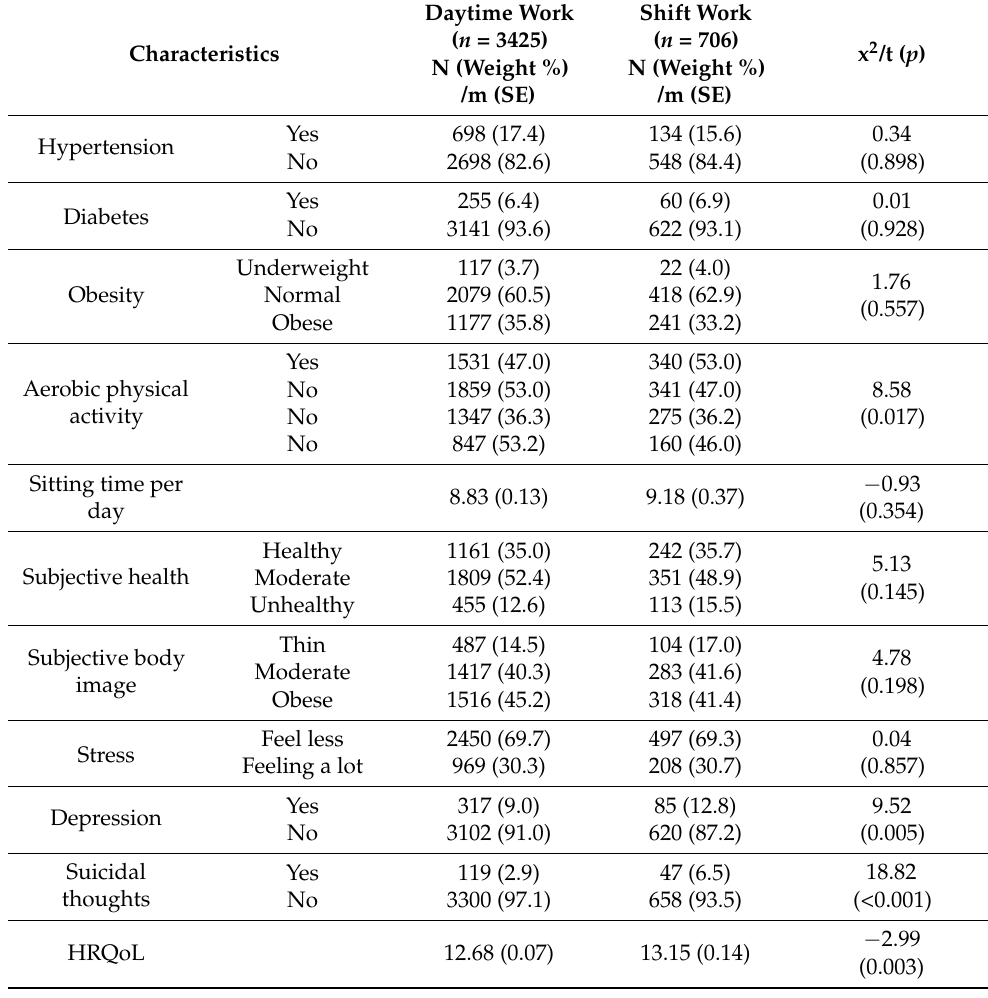
Table 2. Comparison of physical, psychological factors (N = 4131).